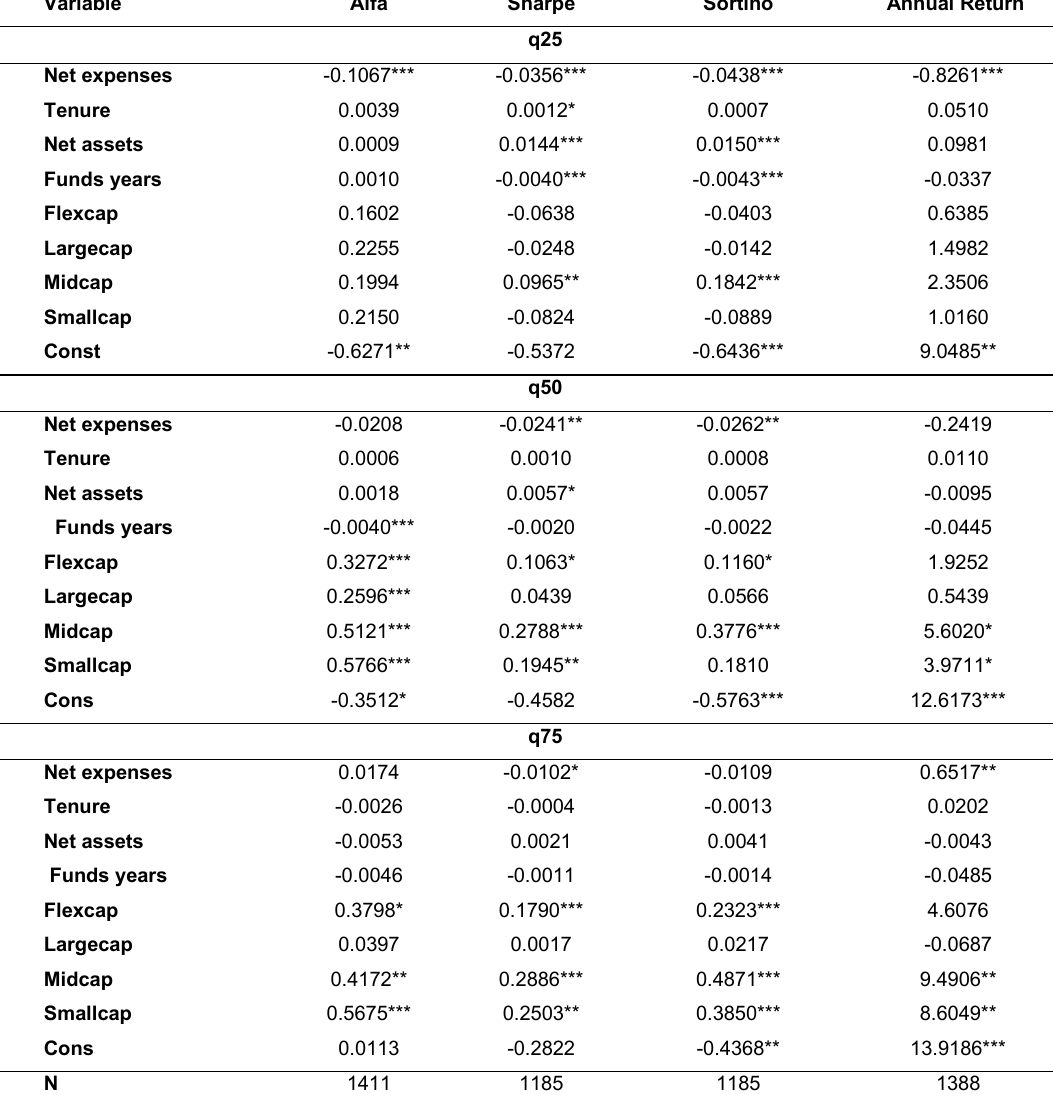
Table 5 . Quantile regression of the relationship between performance and